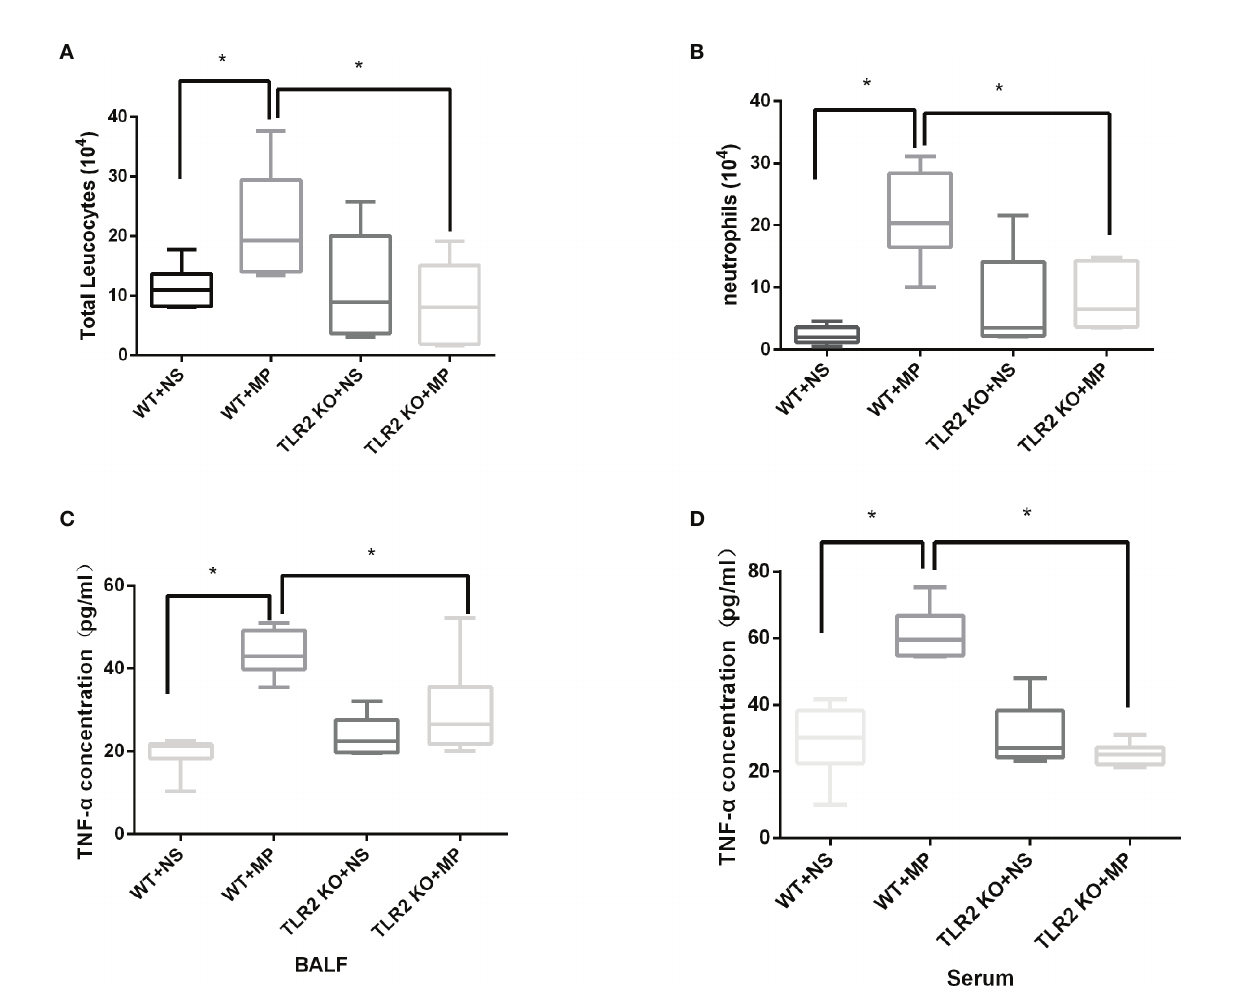
FIGURE 6 | Numbers of (A) BALF total leukocytes, (B) neutrophils, and TNF- a concentration in (C) BALF and (D) serum in wild-type and TLR2 knockout mice. *P < 0.05 is statistically signi fi cant. WT, wild-type mice; TLR2 KO, TLR2 knockout mice; NS, normal saline; MP, Mycoplasma pneumoniae ; BALF, Bronchoalveolar